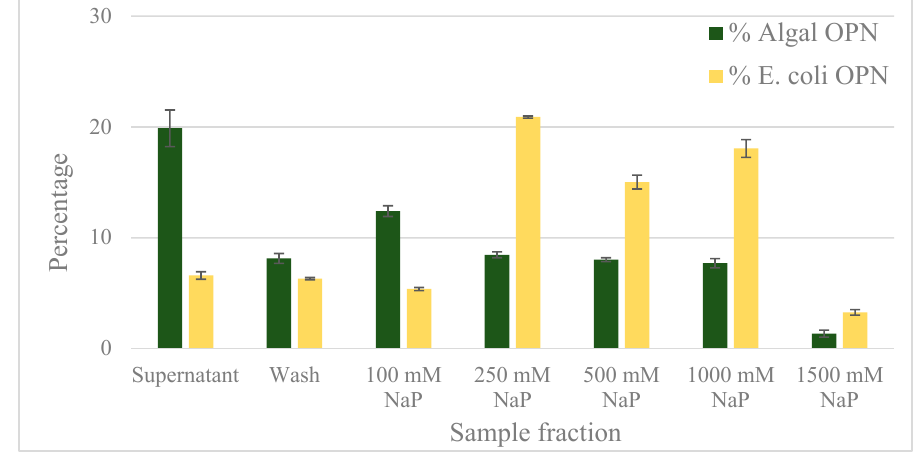
Figure 7. OPN distribution in fractions obtained with Ga-IMAC resin. Adsorption and elution was done in the presence of 500 mM NaCl. Step elutions were performed with sodium phosphate (NaP) buffer, pH 5.5. Data (% OPN) were generated by ImageJ analysis of anti-FLAG western blots and normalized by the amount in the lysate. Error bars indicate standard deviation of triplicate ImageJ measurements.